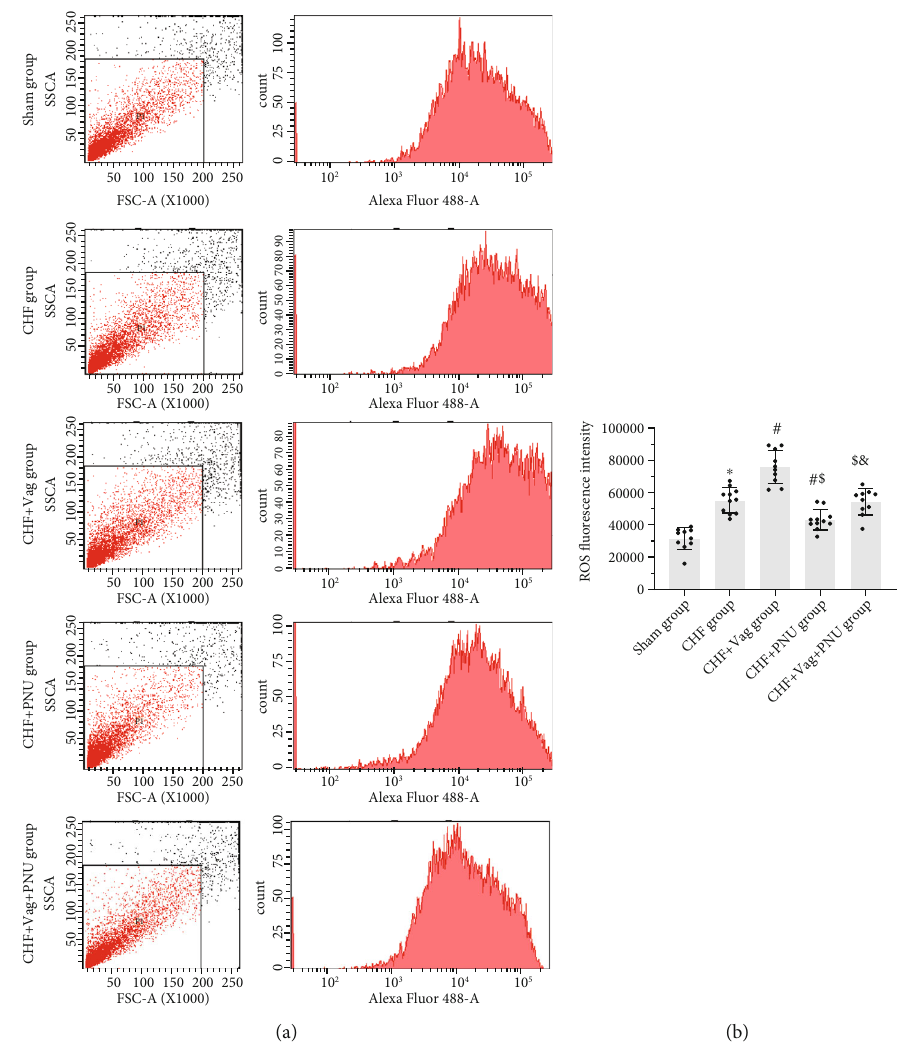
Figure 7: E ff ects of cholinergic elicitation on cardiac ROS production. Typical images of ROS production by fl ow cytometry among fi ve groups (a) and the related quantitative analysis (b). ∗ P < 0 : 05 vs. Sham group. # P < 0 : 05 vs. CHF group. $ P < 0 : 05 vs. CHF+Vag group. & P < 0 : 05 vs. CHF+PNU